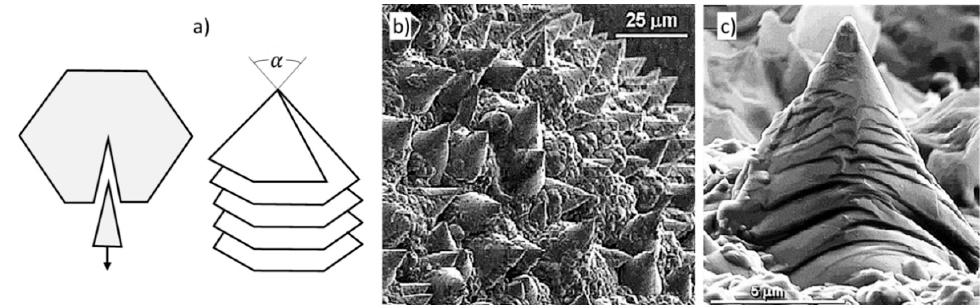
Figure 12. Positive wedge disclination producing cone-helix growth: ( a ) Schematic representation; ( b ) graphite cones on a quasi-spherical metamorphic graphite, reproduced from [46] with permission from Elsevier; ( c ) magnification of picture in ( b ), reproduced from [46] with permission from Elsevier. When inserting a wedge into the basic hexagon a negative wedge disclination defect is produced (Figure 13a). It was used to explain macro-spiral growth in metamorphic graphite (referred to as helical growth in this paper), where upward spiraling plates were documented with hexagonal cavities in the middle of the aggregate (Figure 13b).